Question: Provide a publication-style caption for this figure.
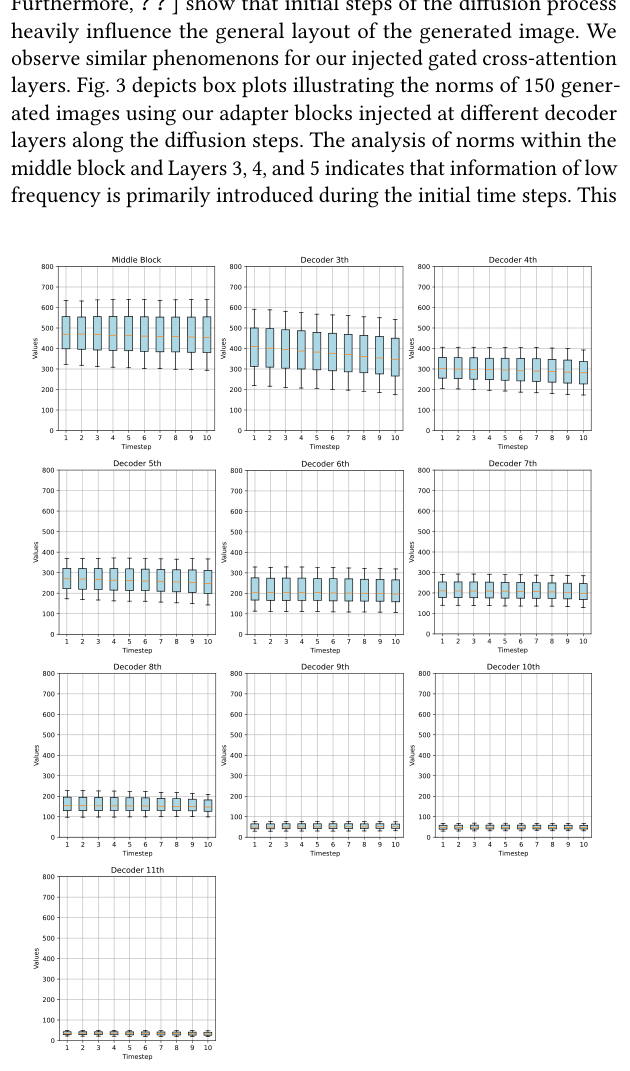
Answer: Norms of gated cross attention outputs across UNet layers. Plots reveals the introduction of low-frequency information in early layers at the initial time steps where as high-frequency details are encoded in higher layers.